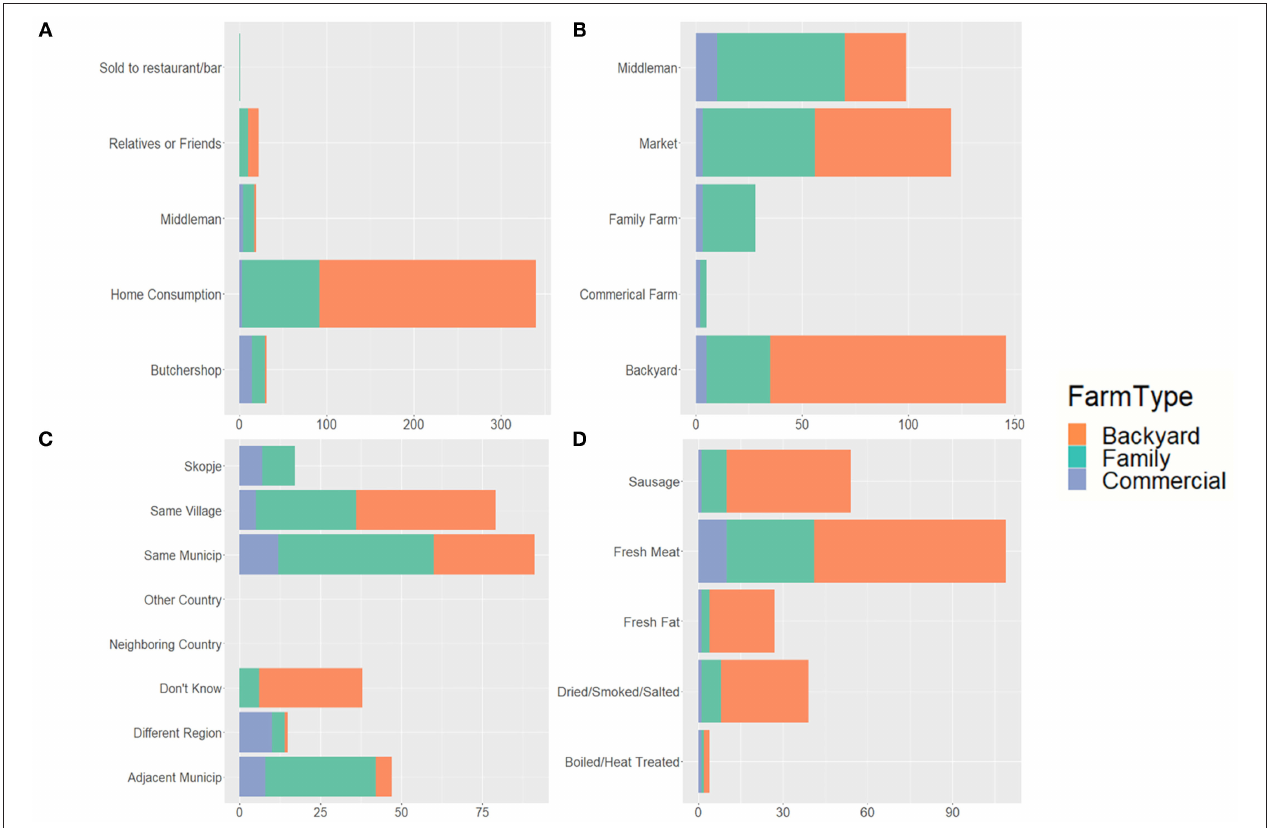
FIGURE 4 | North Macedonian producer’s pig selling practices by farm type by (A) fate of products sold, (B) who producers were selling to, (C) location of buyers, and (D) product type produced by farm, based on questionnaires administered between September 2019 and March 2020 (281 backyard, 146 family, and 30 commercial farms). One producer did report selling to pork products to Bulgaria. Due to survey wording, sausages cannot be differentiated as fresh vs. cooked or